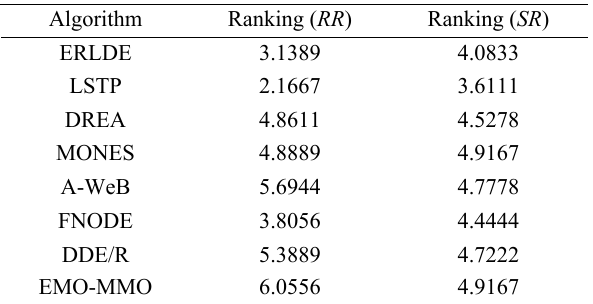
Table 10 Average rankings of ERLDE, LSTP, DREA, MONES, A-WeB, FNODE, DDE/R, and EMO-MMO in and by the Friedman test.